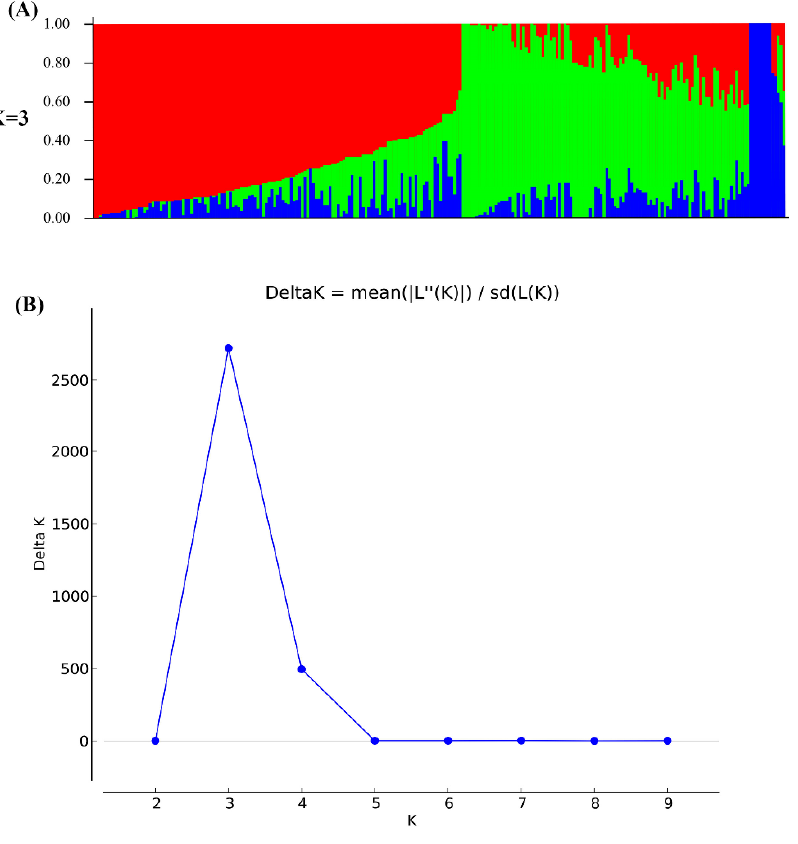
Figure 2. Population structure of 250 soybean accessions using 16,174 SNPs on soybean genome. ( A ) population structure ( k = 3). Each vertical column represents one individual, and the red, green, and blue color segments in each column represents the percentages of cultivated, landrace, and mixture subgroups, respectively; ( B ) the determination for the number of subgroups via the Delta method of Evanno et al. [55]. Table 2. Summary of QTNs identified in four environments and their BLUP values using six ML-GWAS methods.